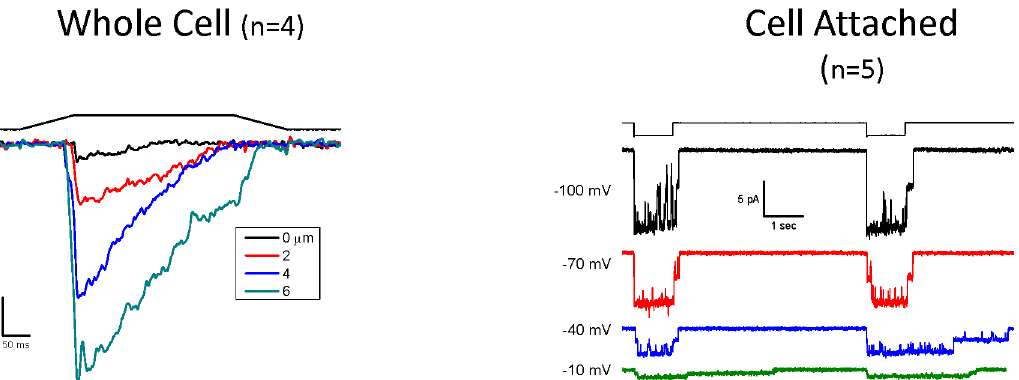
Fig 5. Mutations to the C-terminal fragment alter the inactivation properties of the split protein channel. Two mutations were made to the C-terminal fragment called M2556R and R2456K that are known to remove inactivation in the intact protein. When we expressed the split protein with the mutations made to the C-terminus, we observed an apparent slowing of inactivation for whole-cell (left) and for the single-channel currents (right) there was a loss of inactivation. Whole-cell recording was done at -60 mV with the indicated stimulus pulse above the current traces. Single-channel recordings were done at the indicated voltages with a suction of -30